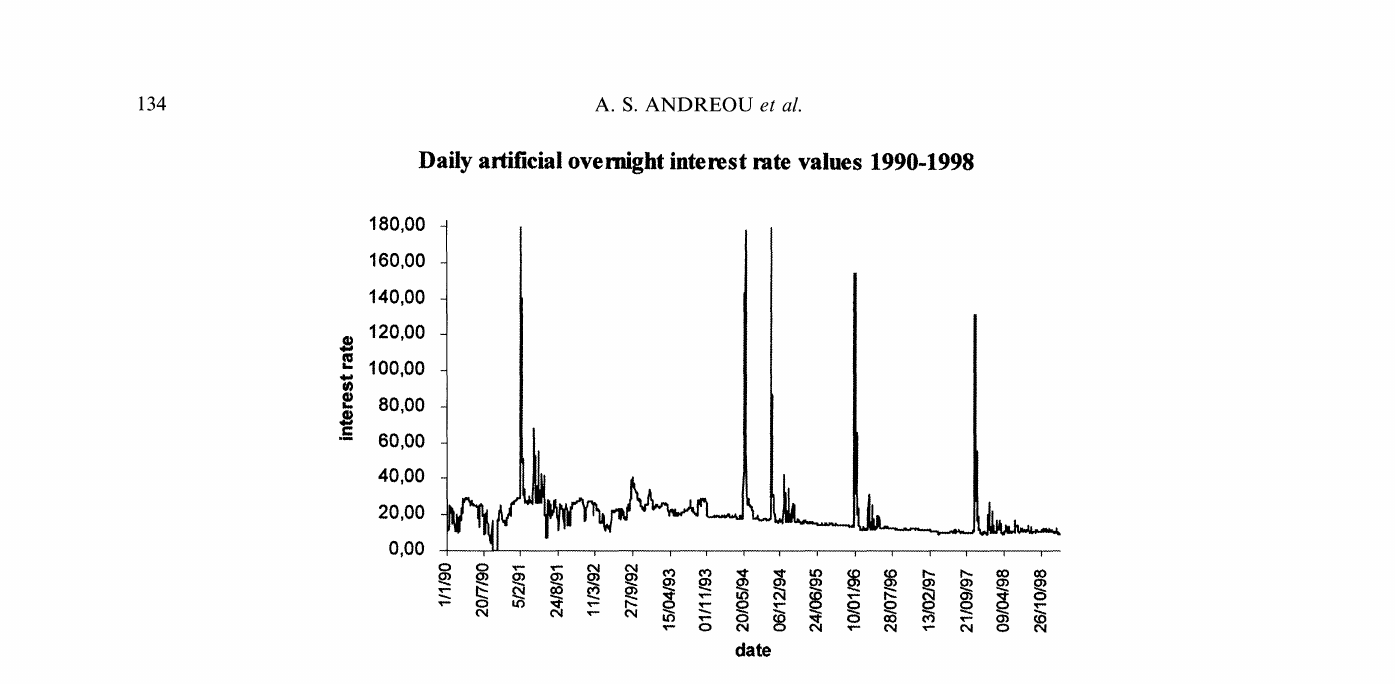
FIGURE 5 Daily values for the Greek overnight interest rate enriched with periods of artificial attacks against the drachma. TABLE III Evaluation of artificial interest-rate prediction during the training and testing phases for a one and five-days prediction horizon Training phase Testing phase Horizon Network architecture*